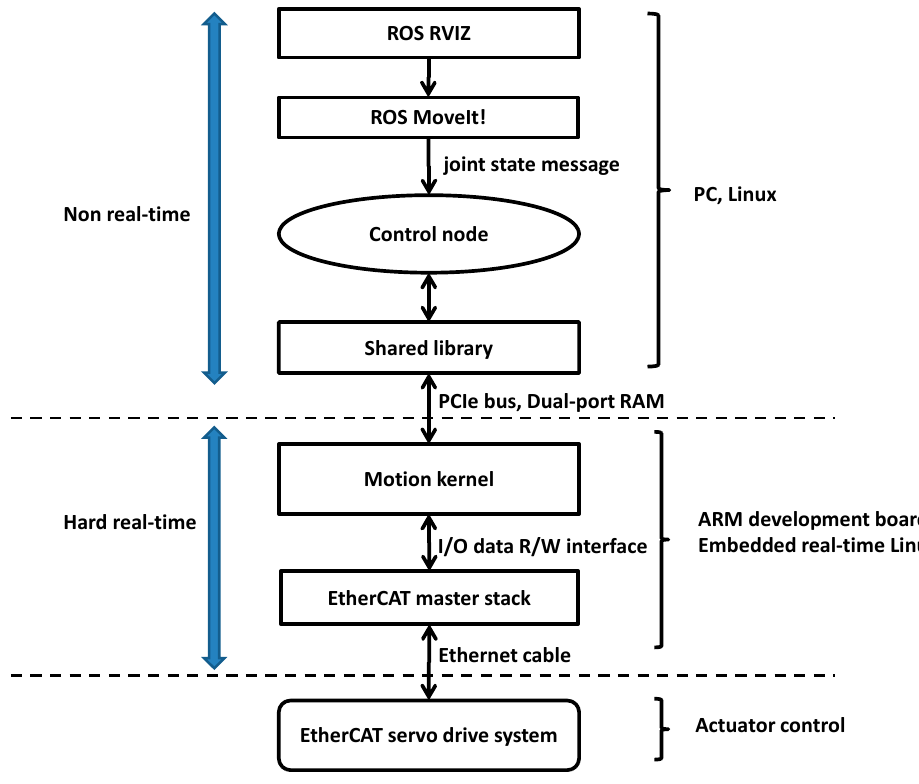
Figure 2. Data flow diagram in proposed ROS control architecture.